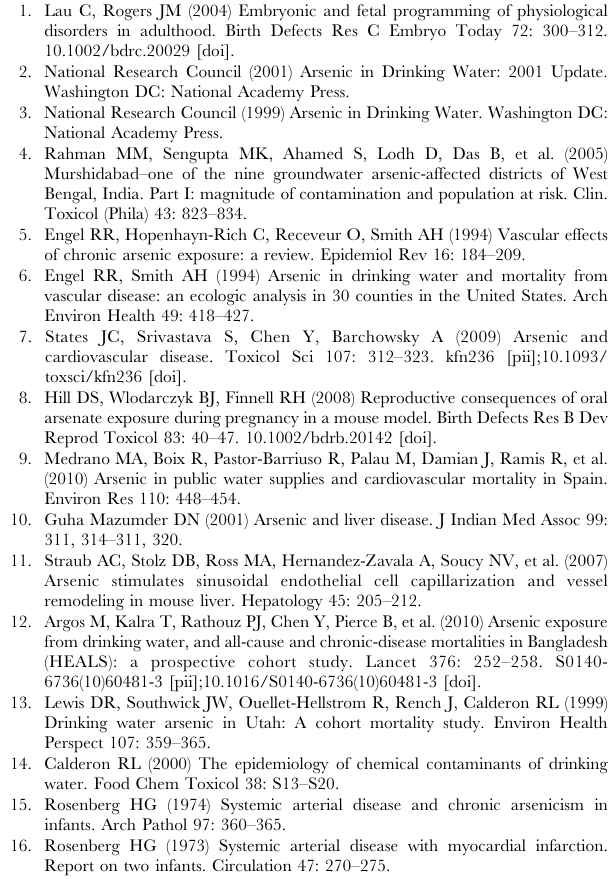
factor binding sites. A total of 135 unique entrez gene IDs are gene targets of up OR down regulated miRNA and appear in the gene list of differentially expressed mRNAs at PND70. A total 28 transcription factors are enriched for this gene set.with a P-value , 0.05. Table S12 Gene promoters of differentially expressed mRNAs that are targets of microRNAs both induced and suppressed in arsenic exposed PND70 mice were analyzed for transcription factor binding sites. A total of 22 unique entrez gene IDs are gene targets of BOTH up AND down regulated miRNA and appear in the gene list of differentially expressed mRNAs at PND70. A total 9 transcription factors are enriched for this gene set.with a P-value ,